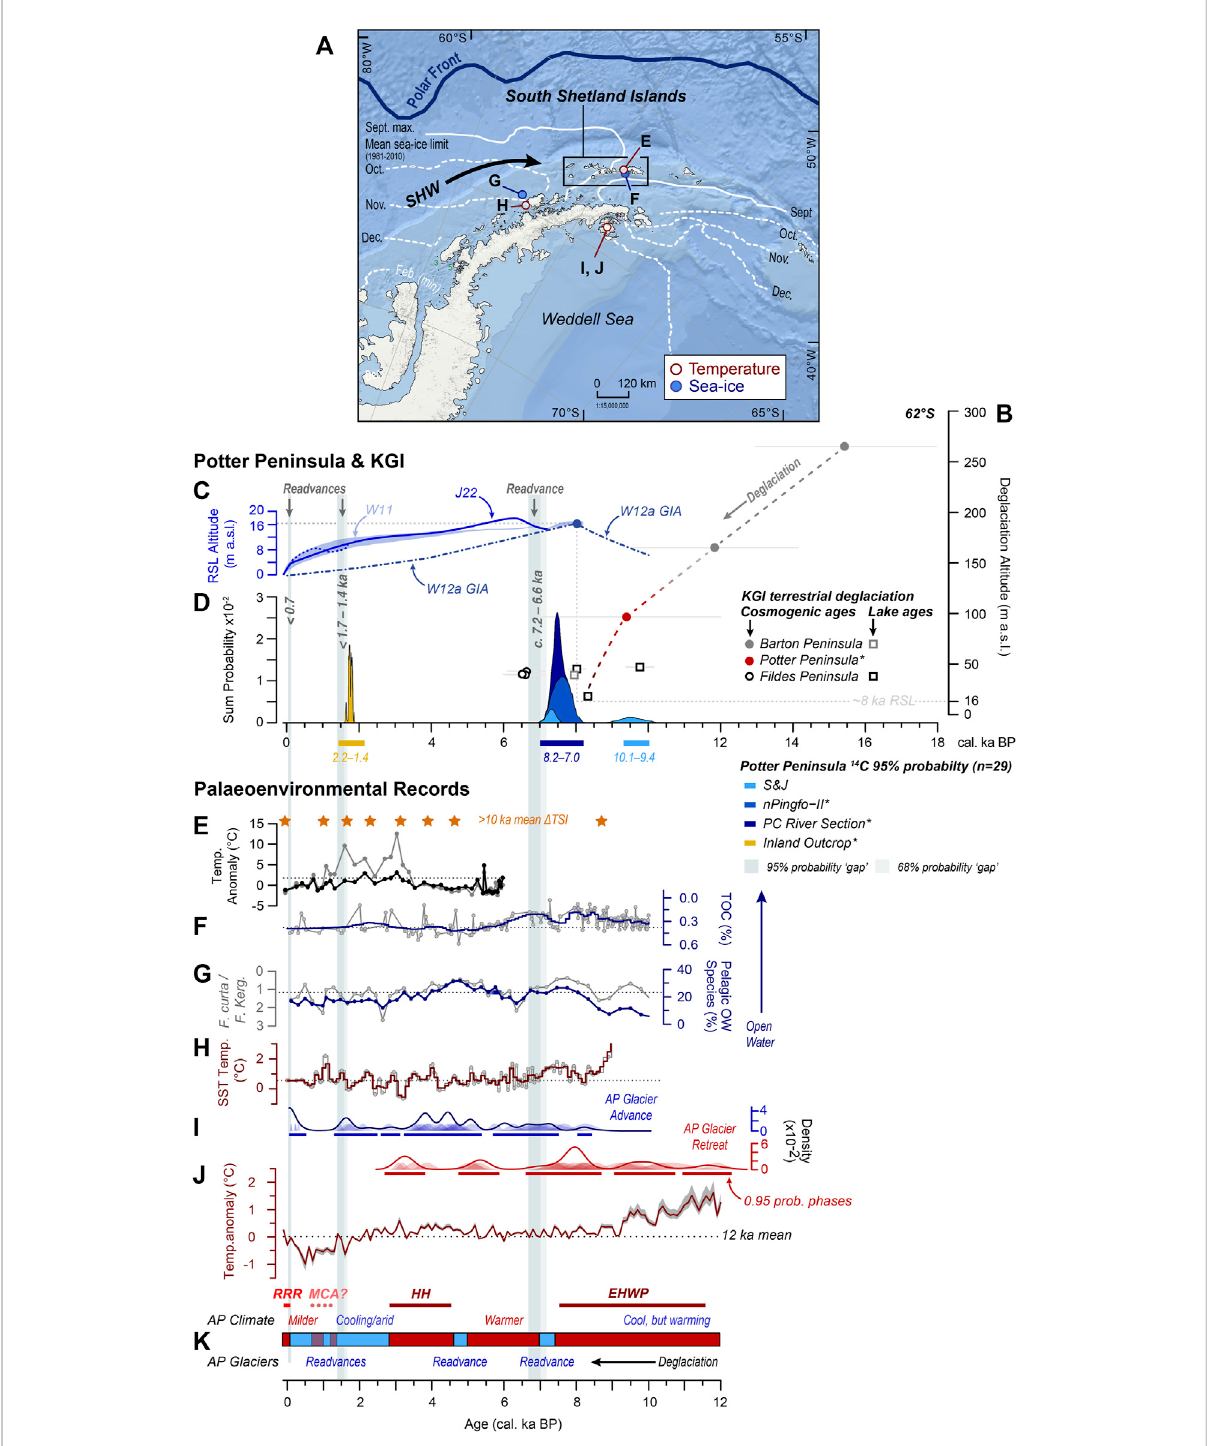
FIGURE 9 (A) Locationmapforpalaeoenvironmentalrecordsinthis fi gure.SHW,SouthernHemisphere Westerlywinds.Letterscorrespondtotherecords shown below. Dashed white lines are mean modern-day sea ice data (NSIDC 1981 – 2010 CE; 20% sea ice coverage from https://nsidc.org/data/ seaice_index/)Australsummerminimum(FebruaryorFeb.)andwintermaximum(SeptemberorSept.)seaicelimits(solidwhitelines).Theminimum (Feb.) sea ice extent on the western side of the AP is located off-image further south of the December (Dec.) sea ice extent. (B) Cosmogenic nuclideexposureagesandkeylakebasal agesconstraining deglaciation onKGIatdifferentaltitudes fromBartonPeninsula(Seongetal.,2008;Oliva et al., 2019), Potter Peninsula (this study), and Fildes Peninsula (Watcham et al., 2011); *, new data (this study). Basal lakes ages constraining early